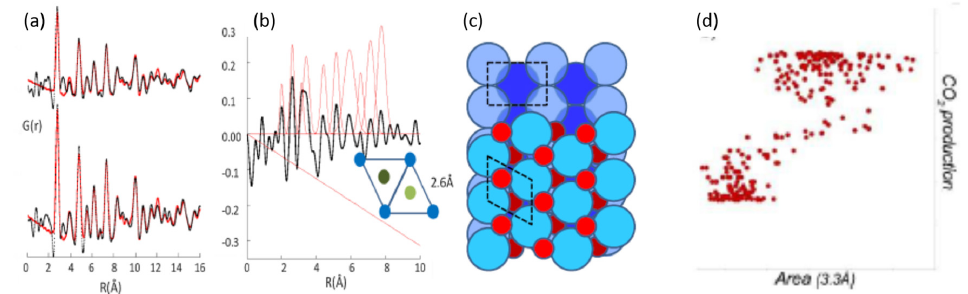
Figure 17. ( a ) Difference PDFs derived from 1 wt % Pt/Al 2 O 3 taken from the ends of the stoich (2CO/O 2 ) cycle (bottom) and the ox (CO/5O 2 ) cycle (top) together with fits made using PDFGui (http://www.diffpy.org/products/pdfgui.html) for spherical nanoparticles of ca. 20 Å in diameter. ( b ) Subtraction of the patterns shown in ( a ) to reveal the scattering differences between the two catalyst states present in the stoich and ox cases. The red curves are those fitted to the data. ( c ) The PtO 2 adlayer structure derived from the pattern of scattering features derived by the difference shown in ( d ) Correlation of the non-fcc scattering feature with the levels of CO 2 measured by online MS. Reproduced with permission from J. Am. Chem. Soc. 2012 , 134, 5036–5039 [163]. Copyright 2012, American Chemical Society.